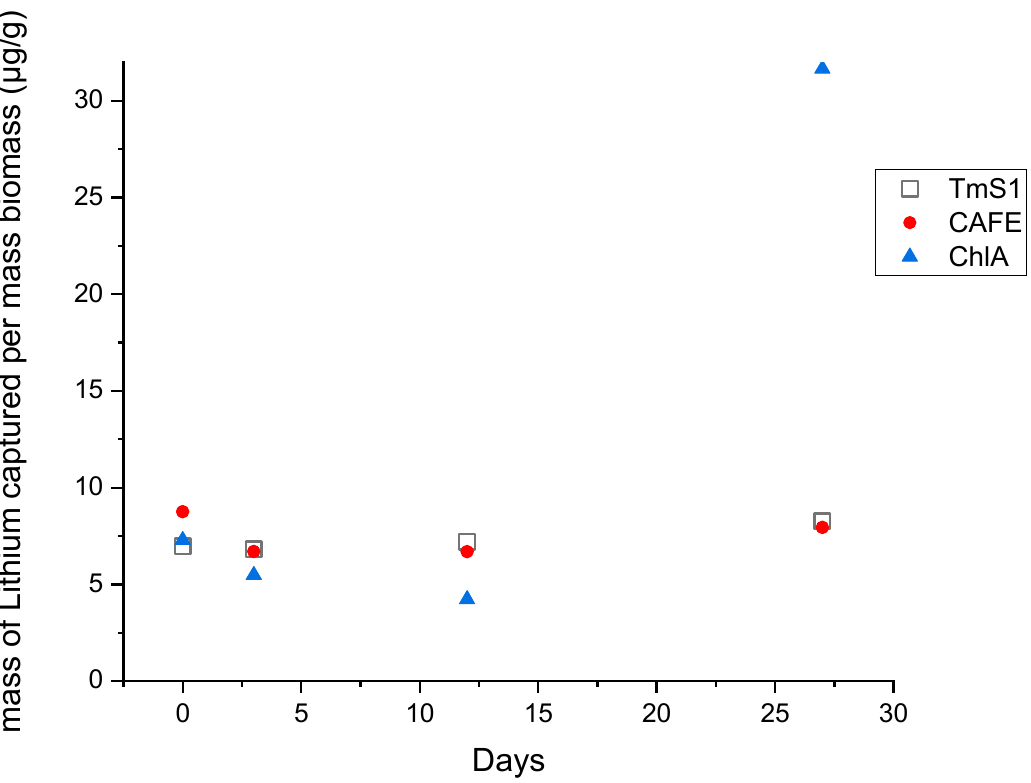
Figure 1. Li capture relative to total biomass in the experimental cultures with additional Li.